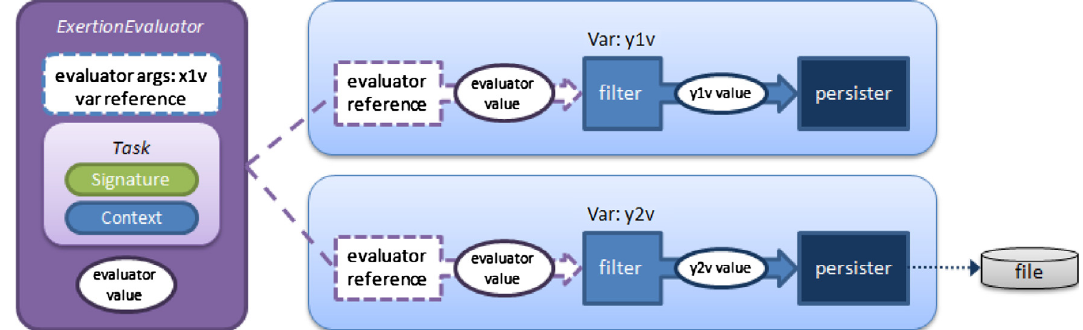
Figure 3. A single Evaluator object may be referenced by multiple Var objects employing different filters to reduce aggregate data to scalar values; the values may be then written to a file (or object field) using a var’s